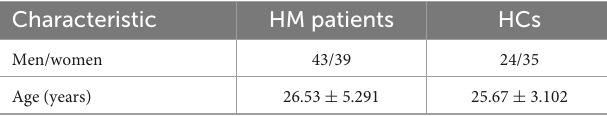
TABLE 2 Demographic characteristics of HM patients and